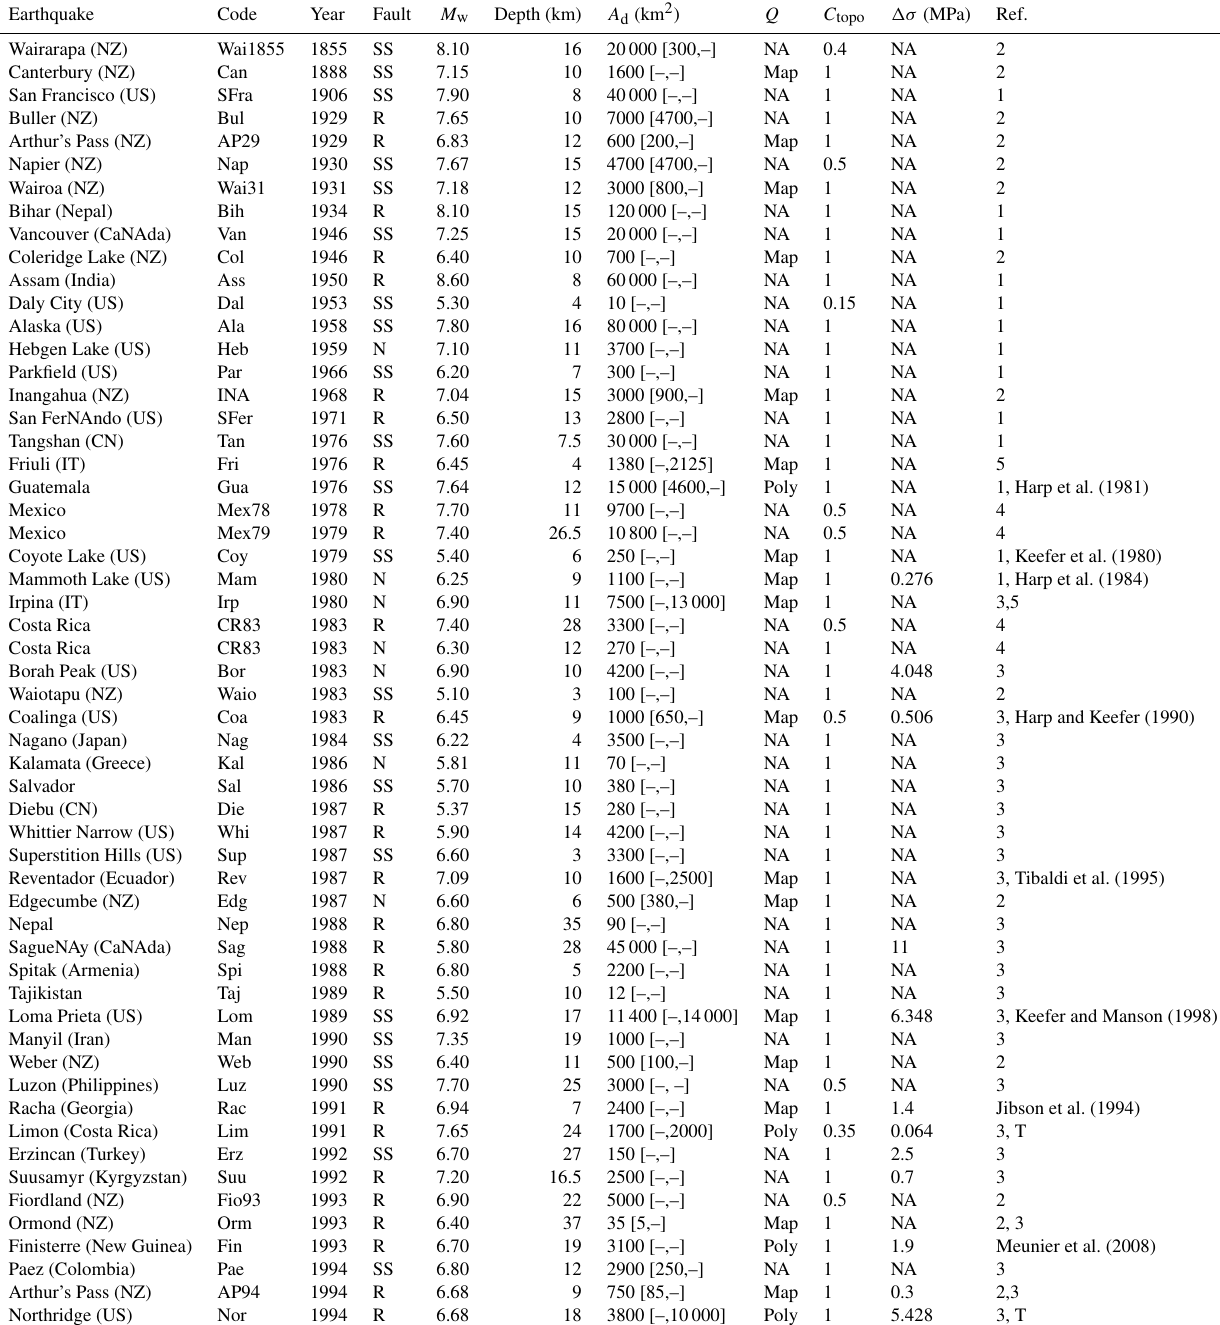
Table 1. Data summary. Earthquake location and country where US, NZ, CN, and IT are for United States, New Zealand, China, and Italy. Fault gives the focal mechanism (reverse, strike-slip, or normal). Depth is the hypocentre depth. The best estimate of A d is followed by lower and upper bound into brackets. Q indicates if a map or an inventory with polygons could be accessed. (cid:49)σ refers to the dynamic stress